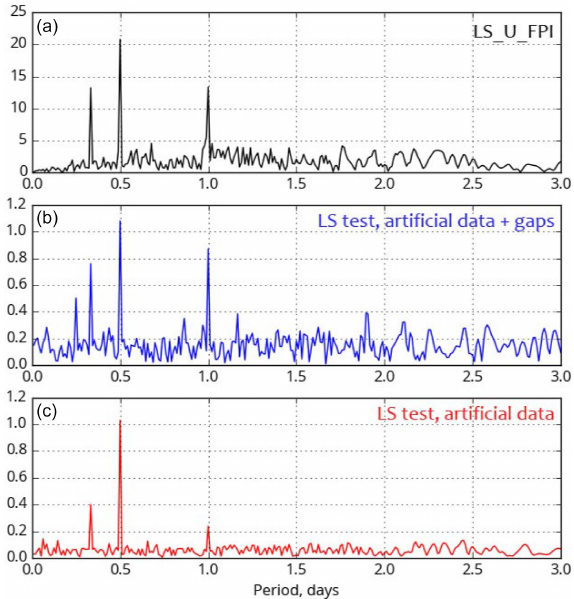
Figure 16. LS periodogram. (a) LS for the zonal wind variations observed during the 2017–2018 winter. (b) LS of the described ar- tificial data sample but with the same gaps (daytime, moonlight, clouds) of the observed zonal wind during the 2017–2018